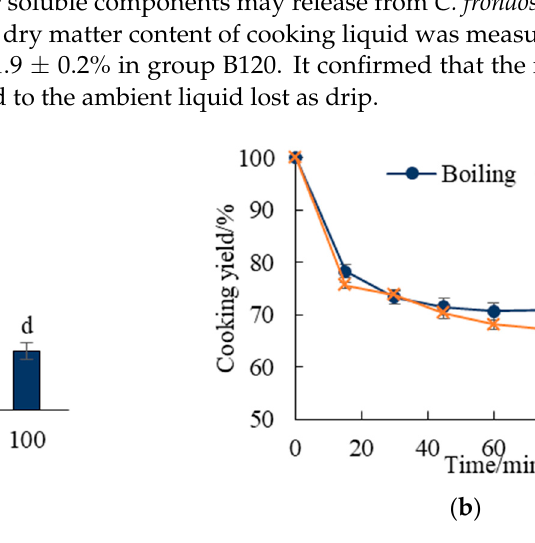
Figure 1. Cooking yield of C. frondosa after various heat treatments, ( a ) comparison of cooking yield during cooking for 45 min at different temperatures (40, 60, 80, and 100 °C), and ( b ) comparison of cooking yield after boiling and steaming at 100 °C for 0–120 min. Different letters (a,b,c,d) indicate significant differences between groups as determined via one-way ANOVA ( p < 0.05).